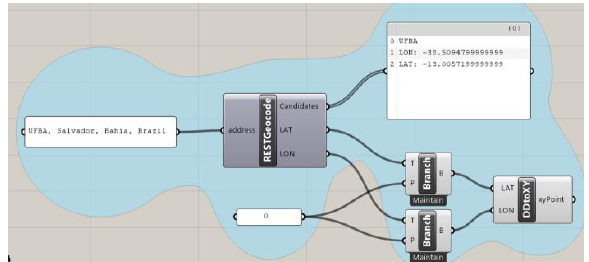
Figure 10: Geocodification of the address of the study field